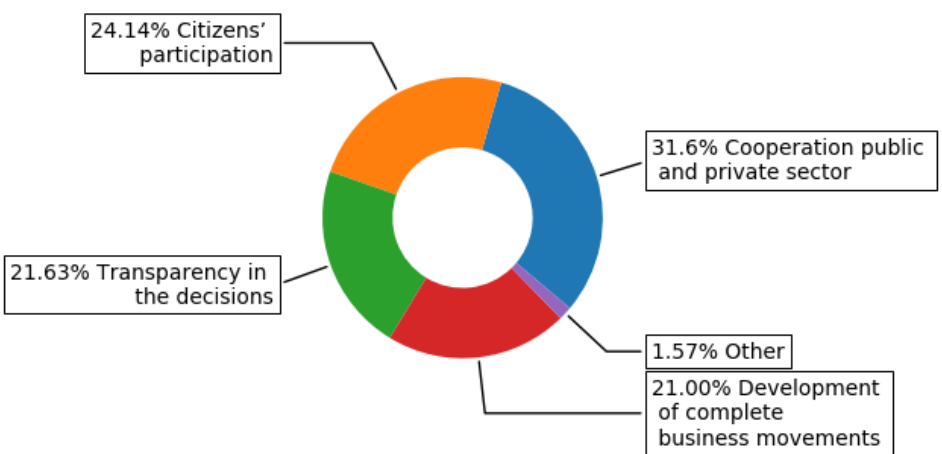
Figure 7. Challenges based on participant’s